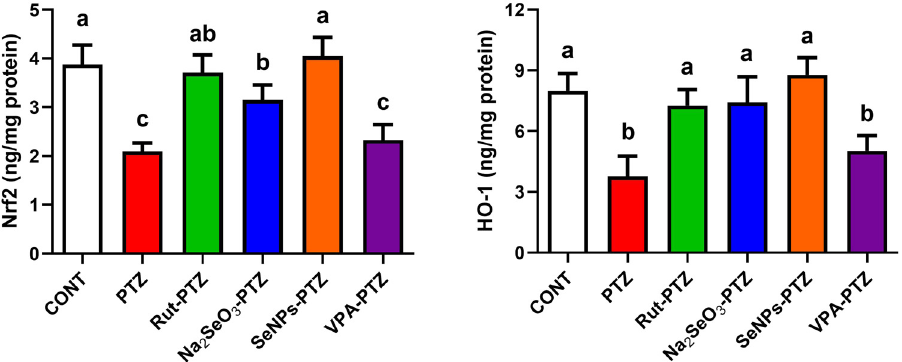
Figure 5: E ff ects of orally administered Rut, Na 2 SeO 3 , or Rut - SeNPs on the levels of Nrf - 2 and HO - 1 in the hippocampus of PTZ - injected epileptic mice. Di ff erent superscript letters indicate statistical signi fi cance at P < 0.05. All results are presented as the mean ± SD.